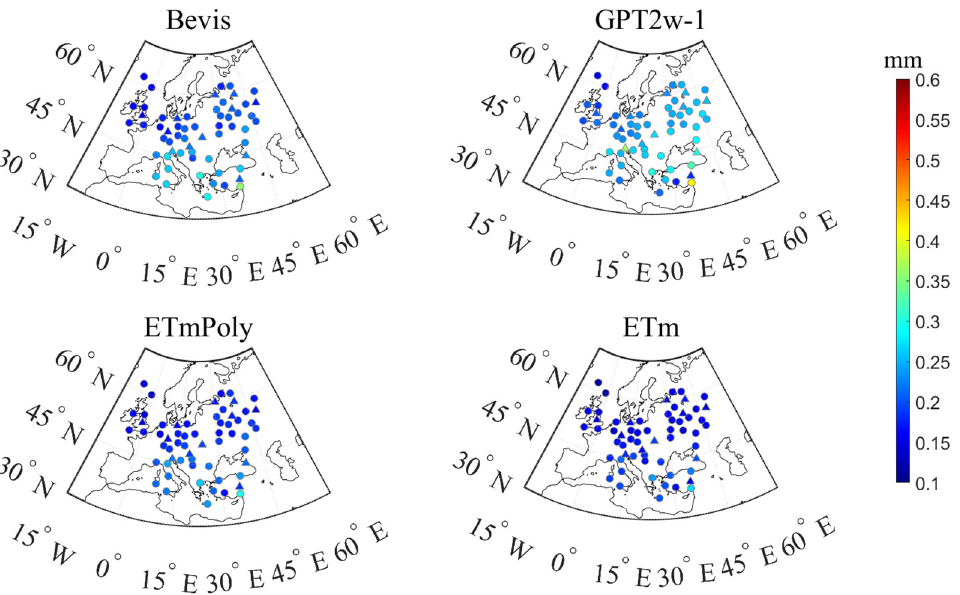
Figure 9. The theoretical RMS of PWV resulting from four different models using radiosonde data in 2021.